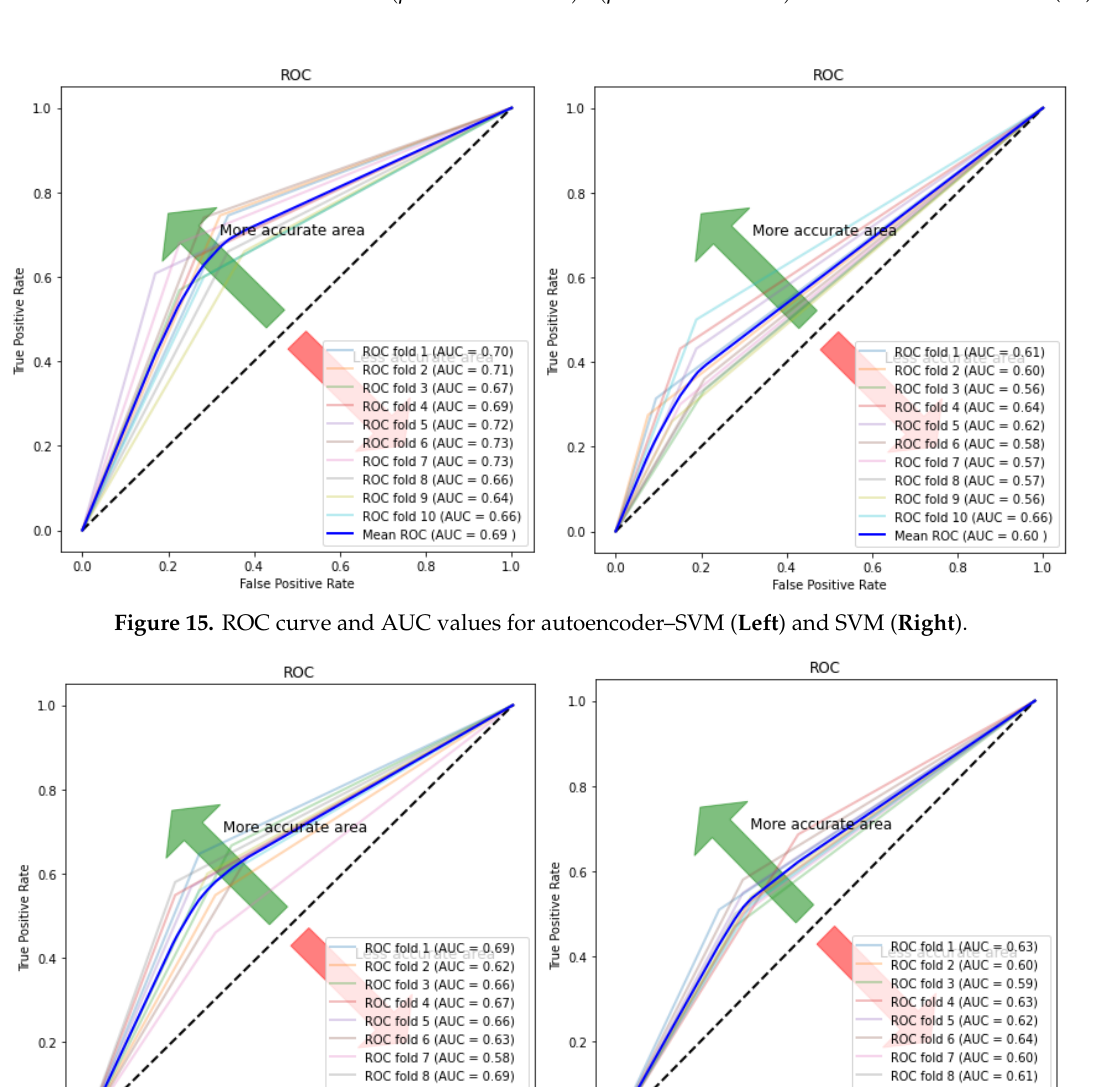
Figure 14. ROC curve and AUC values for autoencoder–CNN ( Left ) and CNN ( Right ). ROC: Receiver Operating Characteristics; AUC: Area under the Curve.